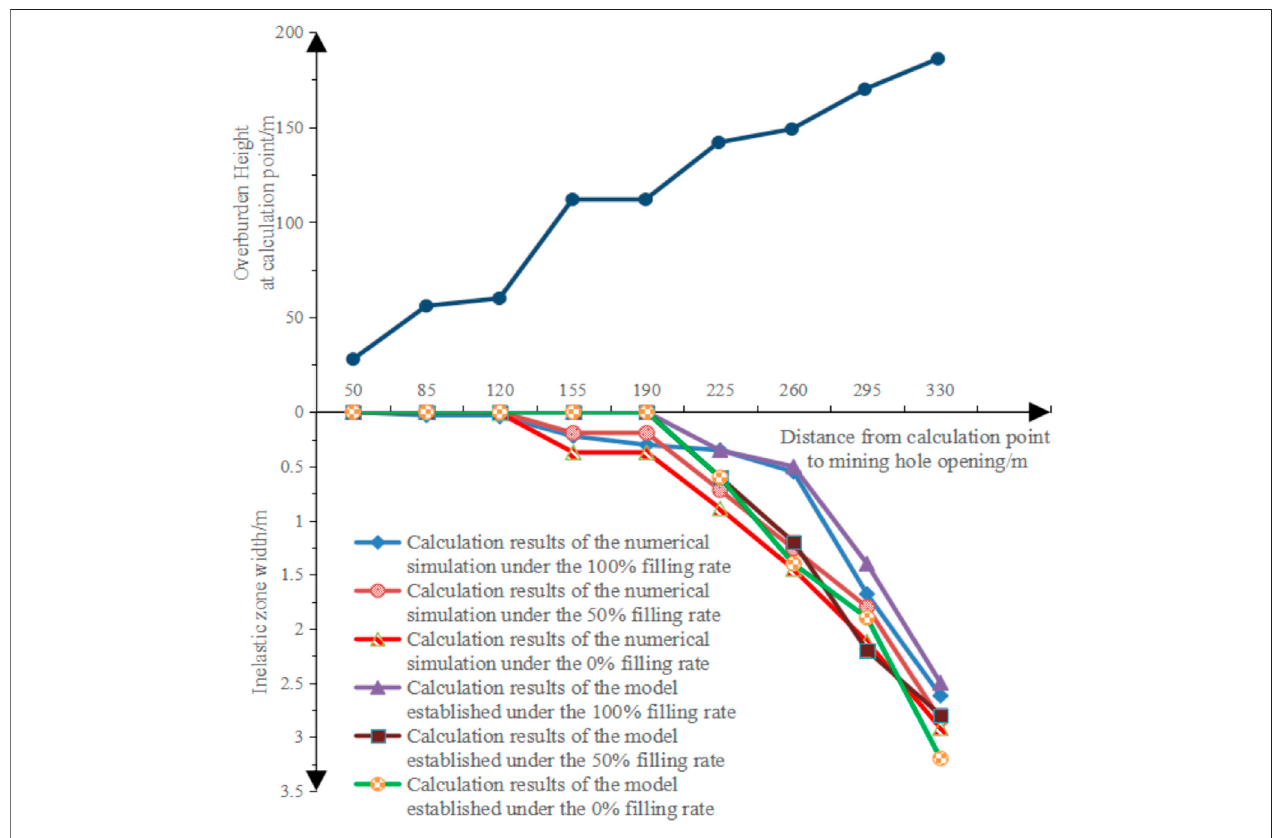
FIGURE 10 | Established model and numerical simulation results.